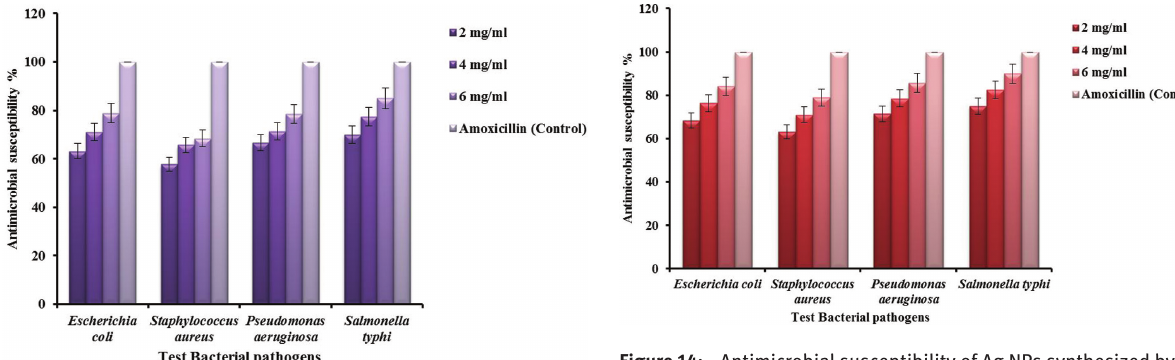
Figure 12: Antimicrobial activity of Ag NPs synthesized by A. bilimbi leaf extract represented in %.